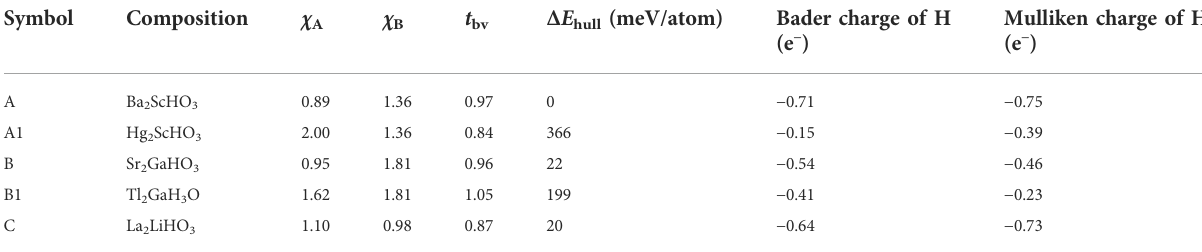
Mulliken charge of H (e − ) (e − )